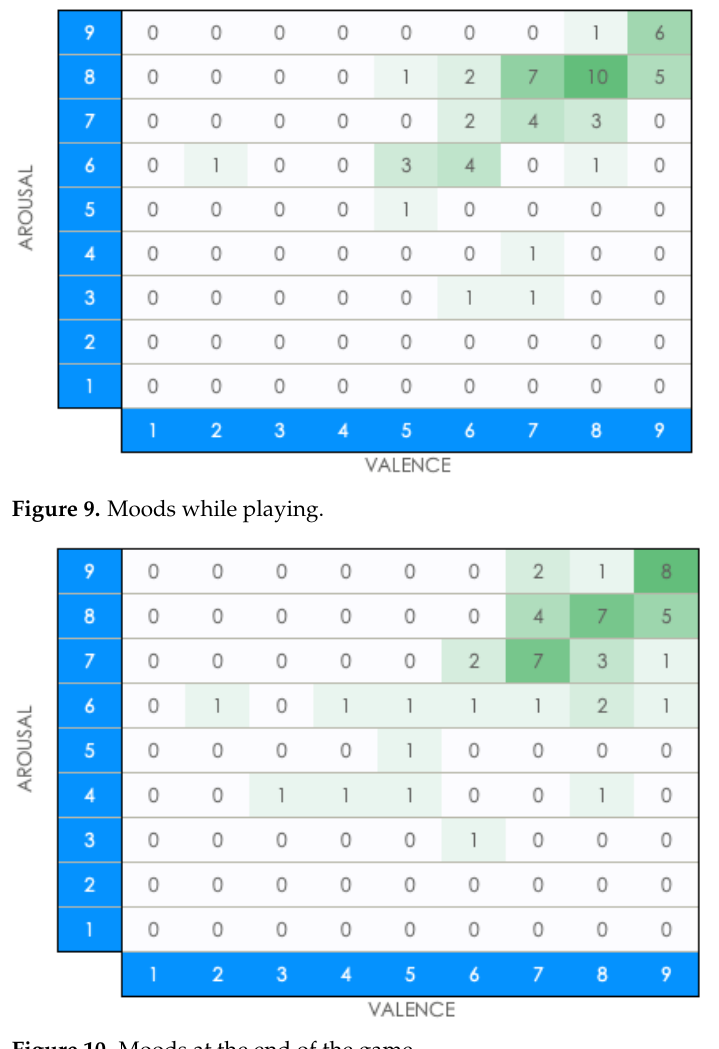
Figure 10. Moods at the end of the game.